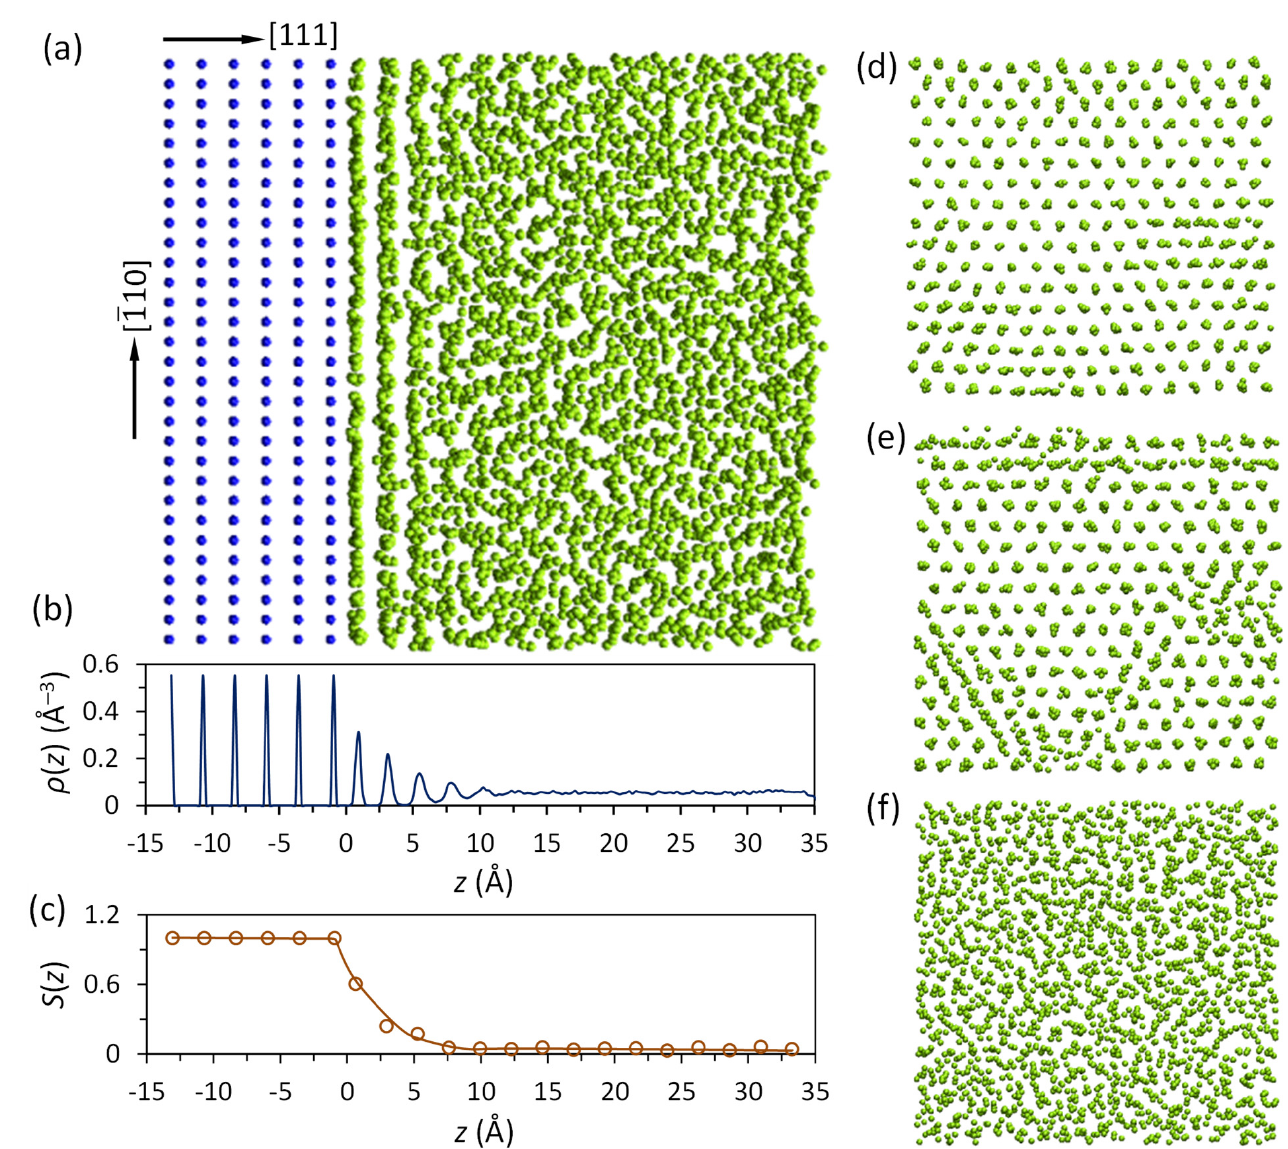
Figure 1. Prenucleation manifested by atomic layering and in-plane atomic ordering at the liq- uid/substrate interface [18]. A generic liquid/substrate system with − 2% misfit has been equilibrated at 900 K for 1 ns. ( a ) A snapshot showing the time-averaged atomic positions in the system; ( b ) the quantified atomic density profile, ρ ( z ), and ( c ) in-plane order parameter, S ( z ), as a function of distance ( z ) away from the interface for the system showing that atomic layering in the liquid persists within six atomic layers at the interface, with significant in-plane atomic ordering within the first two atomic layers. The time-averaged atomic positions in ( d ) the first layer (L1), ( e ) the second layer (L2), and ( f ) the third layer (L3) suggest that L1 and L2 exhibit a mixed structure of ordered and disordered regions, and L3 has a largely disordered structure. The blue and green spheres represent atoms in the substrate and liquid, respectively. (Reprinted with permission from Ref. [18]. Copyright 2022, Spring Nature)